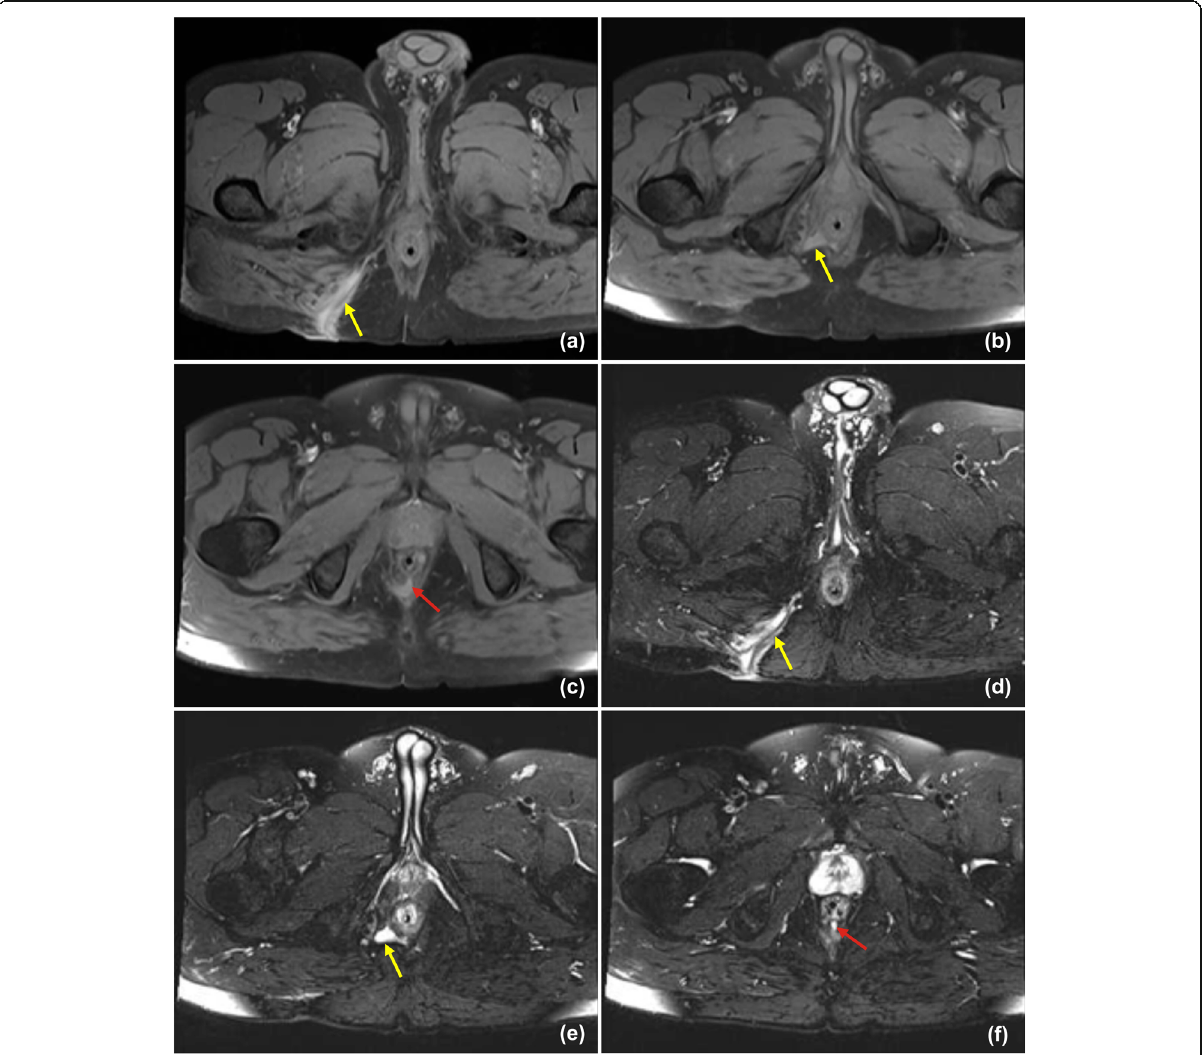
Fig. 15 MR pelvis images of a transsphincteric fistula. a – c FS T1W axial. d – f FS T2W axial images showing the course of track (yellow arrows) and the level of internal opening (red